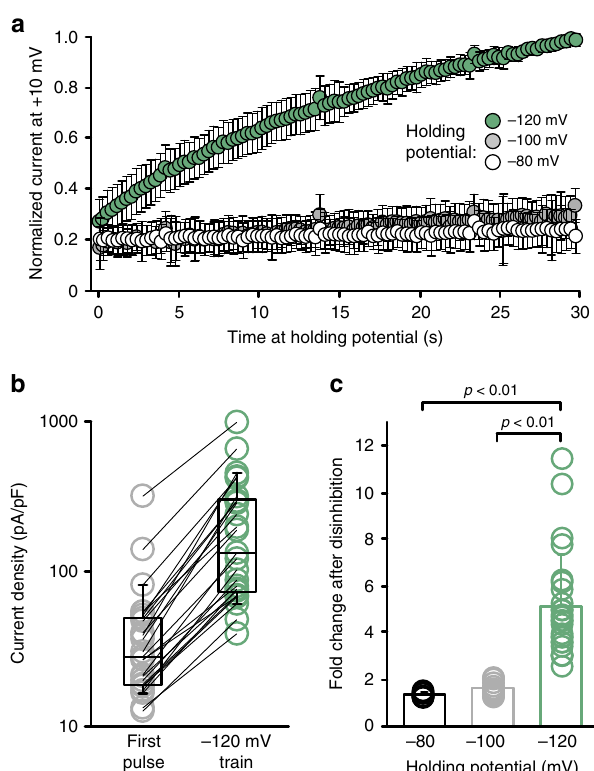
Fig. 3 Hyperpolarization disinhibits Kv1.2 co-expressed with Slc7a5. a ltk - mouse fi broblast cells transfected with Kv1.2 + Slc7a5 (1:1) were held at a range of voltages: − 80 mV ( n = 7), − 100 mV ( n = 12) and − 120 mV ( n = 25). Currents were measured at + 10 mV (50 ms pulses, every 300 ms), and normalized to the peak current after 30 s at − 120 mV (mean ± s.d.). b Cell-by-cell current density (at + 10 mV) of the fi rst (gray) and fi nal (green) pulses of a train of depolarizations with a − 120 mV holding voltage. c Fold change between the initial and fi nal test pulses of a 30 s pulse train with the indicated holding voltages (mean ± s.d.: 1.4 ± 0.1 at − 80 mV; 1.6 ± 0.3 at − 100 mV; 5 ± 2-fold at − 120 mV, ANOVA followed by Dunnett ’ s post